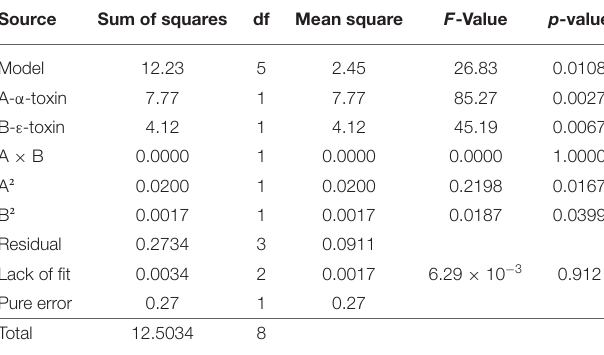
TABLE 4 | Analysis of variance for prevalence of C. perfringens toxinotypes in four different zones of Punjab province in